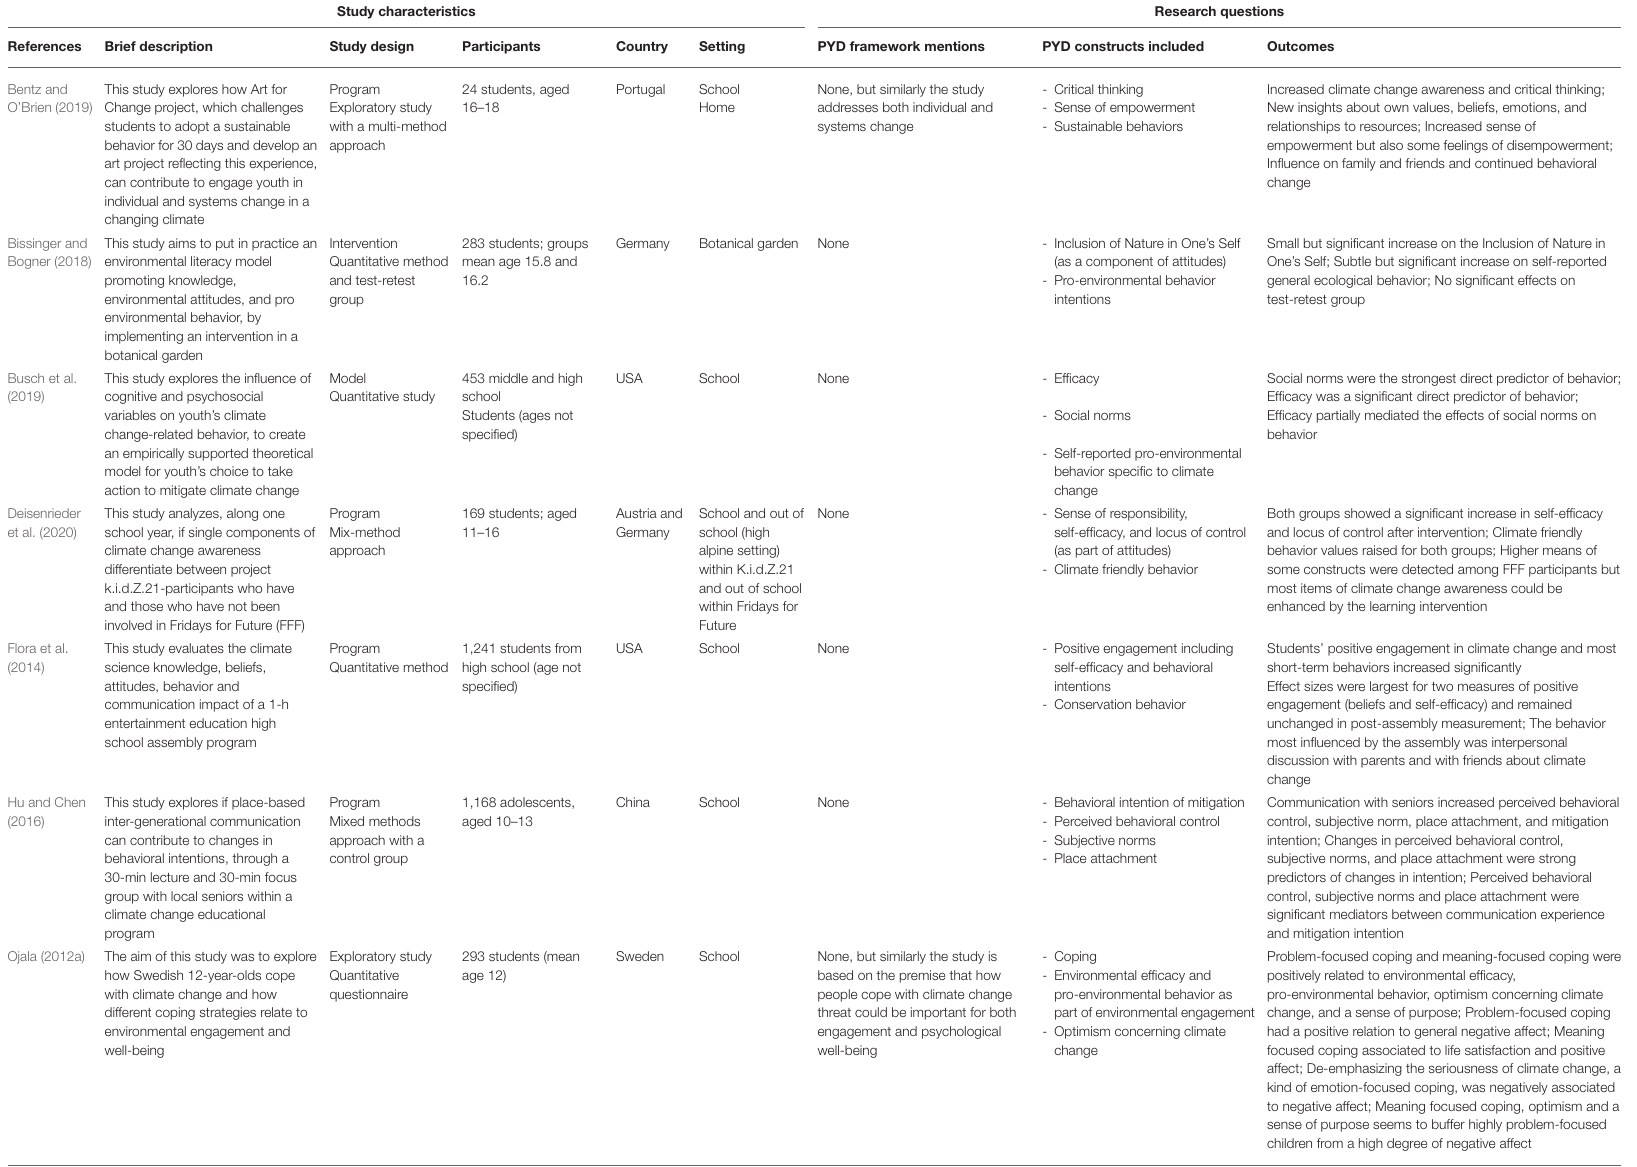
TABLE 2 | Matrix of included